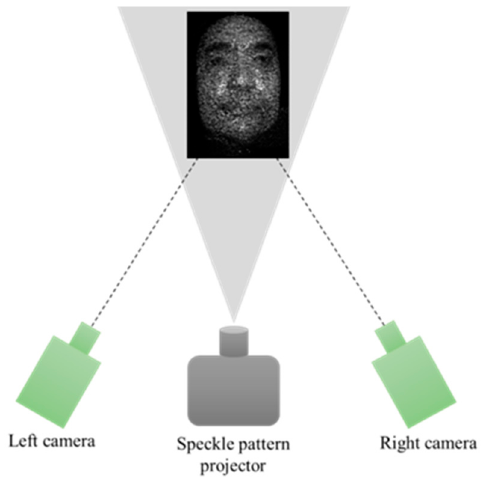
Figure 1. Schematic of binocular stereo vision system using random speckle structured light.